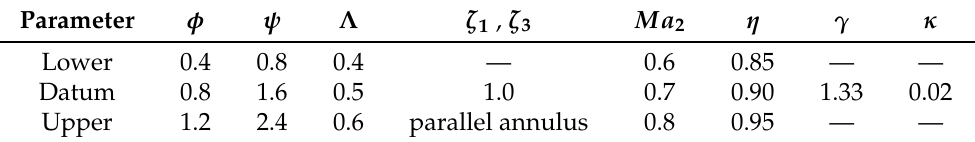
Table 1. Datum values and upper and lower bounds for turbine design parameters.